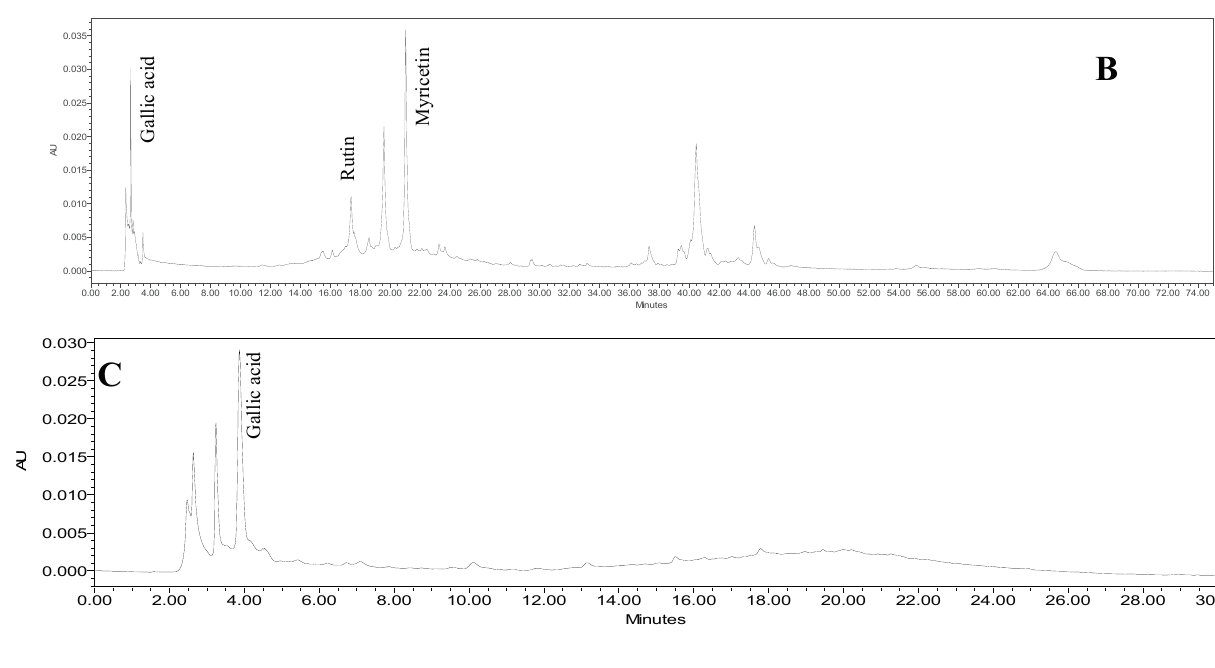
Figure 2. RP-HPLC chromatogram of the 80% ethanol extract of Labisia pumila var. alata at 280 nm ( A ) and 350 nm ( B ), for identification and quantification of 5-( Z -nonadec-14- enyl)resorcinol (compound 1 ) and demethylbelamcandaquinone B (compound 2 ), gallic acid, rutin and myricetin. RP-HPLC chromatogram of the aqueous extract ( C ) of Labisia pumila var. alata at 280 nm for identification and quantification of gallic acid.